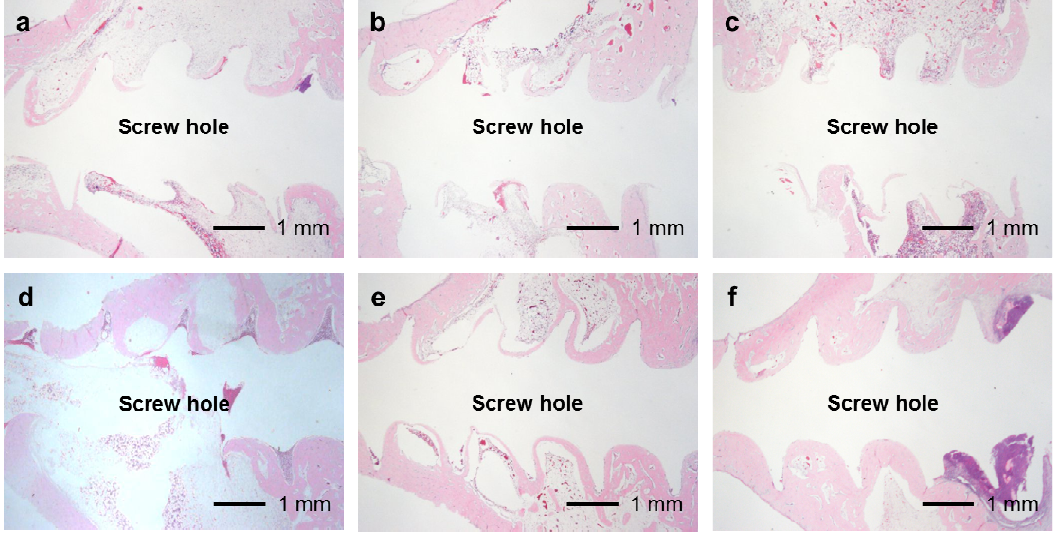
Figure 12. Histological sections showing bone formation in the cortical and medullary cavity regions. No or very little bone formed in the medullary cavity regions in the ( a ) UN1; ( b) 25F0.5; ( c ) 25F1.0; and ( d ) 25F2.0 groups in the Grade 0b (no osteomyelitis) samples. On the contrary, dense bone formed in the medullary cavity regions in the 37F4.0 group in ( e ) the Grade 0b and in ( f ) the Grade 1b (partial osteomyelitis)